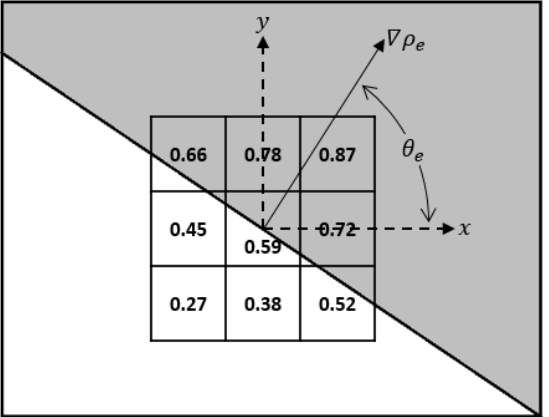
Figure 5. A visualization of the elemental density gradient vector at an element.